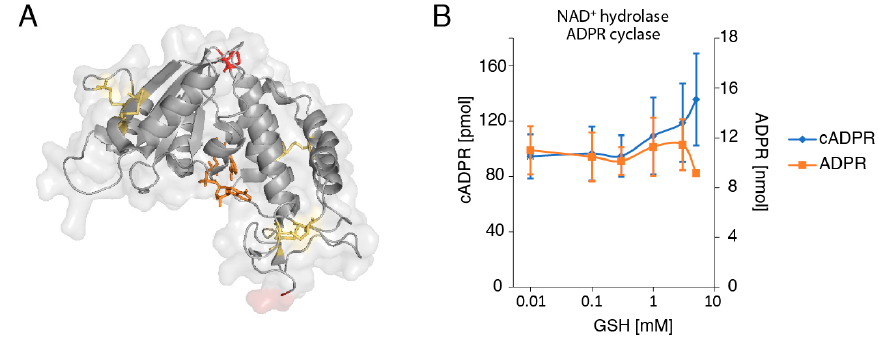
Figure 4. Glutathione enhances the production of cADPR by LP-1 myeloma cells in a dose-dependent manner. ( A ) Schematic illustrating the disulfide bonds in the extracellular domain of CD38. The five conserved disulfide bonds are depicted in yellow, the non-conserved disulfide bridge at C119/C201 is depicted in red. The N-terminal amino acid of the ectodomain of CD38 is shown in transparent dark red-five amino acids that separate this residue from the transmembrane domain of CD38. NAD + in the active site crevice is depicted as an orange stick model. The model was made using the Pymol program and the coordinates of human CD38 in complex with NAD + (pdb 2i65). ( B ) LP-1 cells were incubated for 10 min with the indicated concentrations of GSH before addition of NAD + (500 μ M) and further incubation for 60 min at 37 °C. Concentrations of ADPR and cADPR in cell supernatants were determined by HPLC, as in Figure 1.